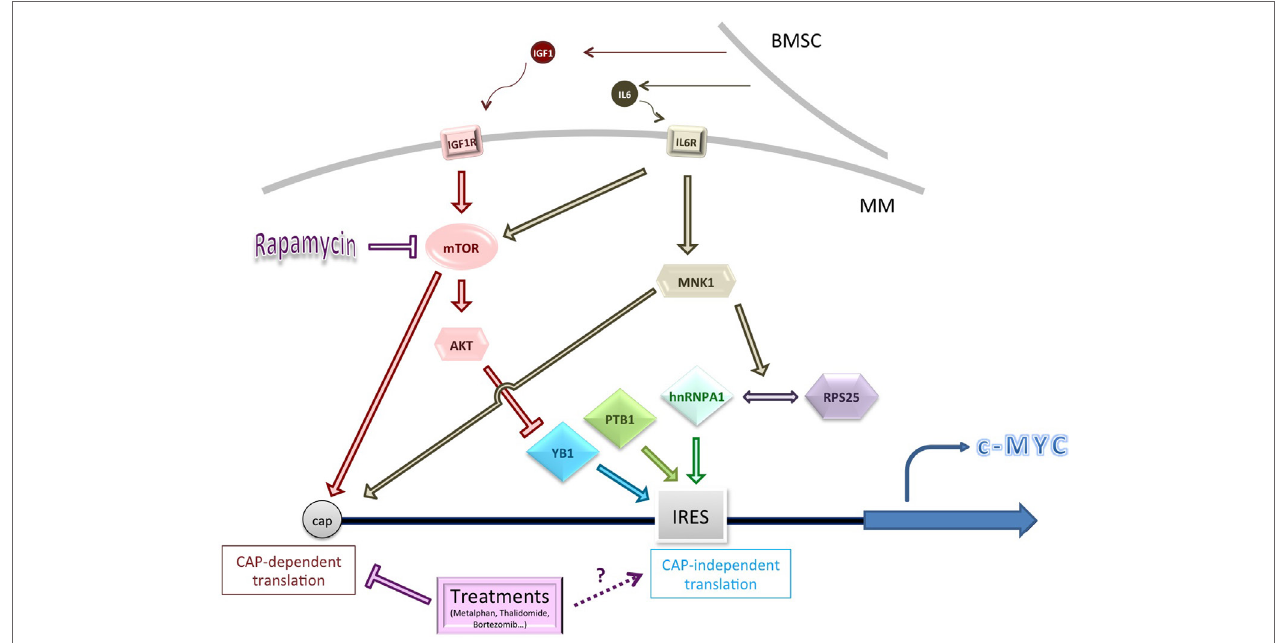
FiGURe 1 | Schematic summarizing some of the genes and pathways known to influence c-Myc cap-independent translation in multiple myeloma (MM) . Cytokine activation of key signaling pathways, or pathway dysregulation, may affect the levels or activity of IRES trans-activating factors (ITAFs), including YB1 (conditions of low Akt activity). MNK1-mediated phosphorylation of hnRNPA1 and/or RPS25 increases interaction between them and might improve ribosome loading on the c-Myc IRES (77). Conventional treatments for MM usually inhibit CAP-dependent translation but their impact on CAP-independent translation is unknown. BMSC, bone marrow stromal